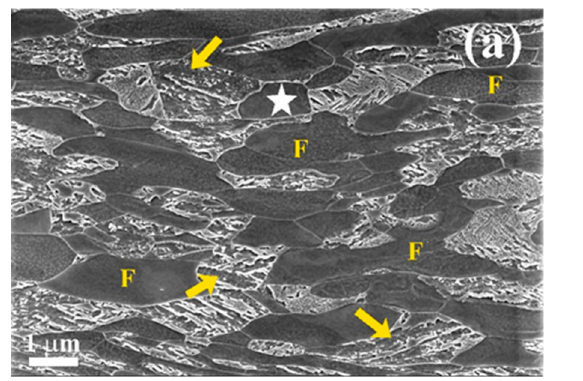
Figure 6. ( a ) SEM micrograph showing the microstructure of a specimen tested to fracture at 175 °C. ( b ) EBSD phase map of ( a ). The deformation-induced structure has been indexed to be bcc phase, as marked by yellow arrows. F: ferrite. Blue color represents fcc phase, red color represents bcc phase, and black color represents unindexed points. White stars are registration marks.